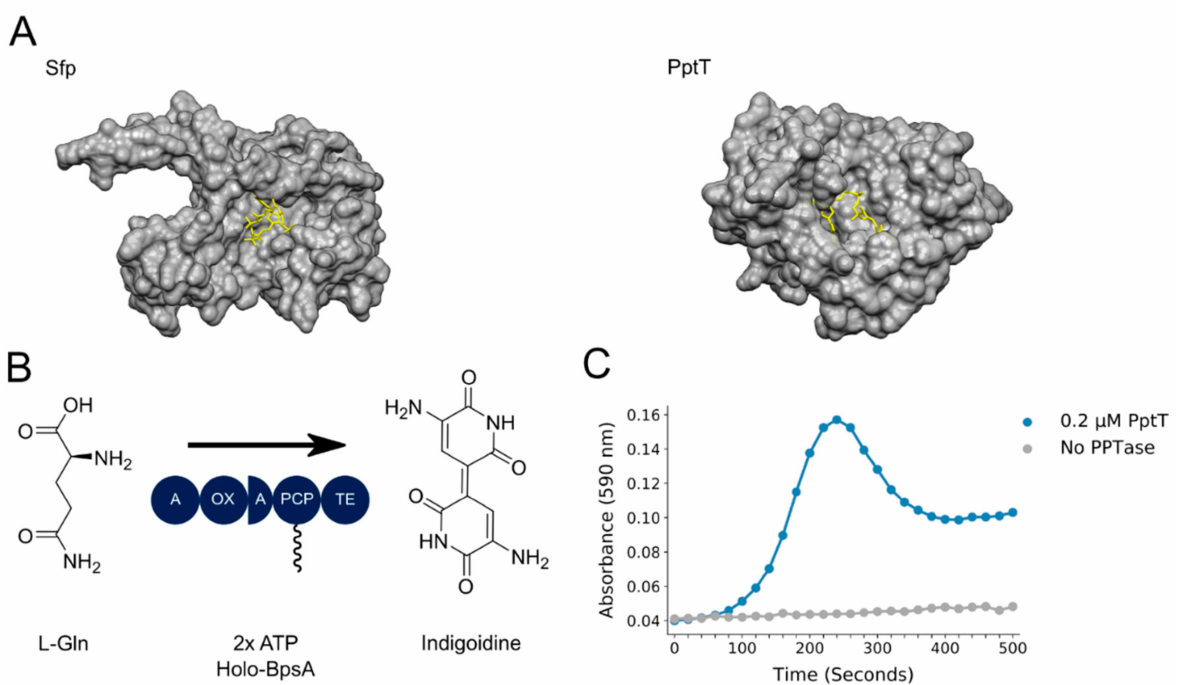
Figure 1. ( A ) Crystal structures of Sfp and PptT, highlighting the orientation of CoA: CoA (yellow) is orientated towards the solvent in the crystal structure of Sfp (PDB: 1QR0), while in our structure of PptT (PDB:4QVH), it is encapsulated by the binding pocket. Visualisation was performed using Chimera [24]. ( B ) Schematic showing biosynthesis of indigoidine by holo -BpsA: Holo -BpsA synthesises indigoidine from two molecules of L-glutamine in an ATP powered reaction. When indigoidine is solubilised in DMSO, it has a characteristic deep blue colouring that can readily be detected by monitoring absorbance at 590 nm. ( C ) Characteristic curve of indigoidine biosynthesis during the activation of apo -BpsA by PptT: Indigoidine production in an aqueous solution yields a sigmoidal curve of absorbance at 590 nm until it reaches saturation and precipitates, after which the A 590